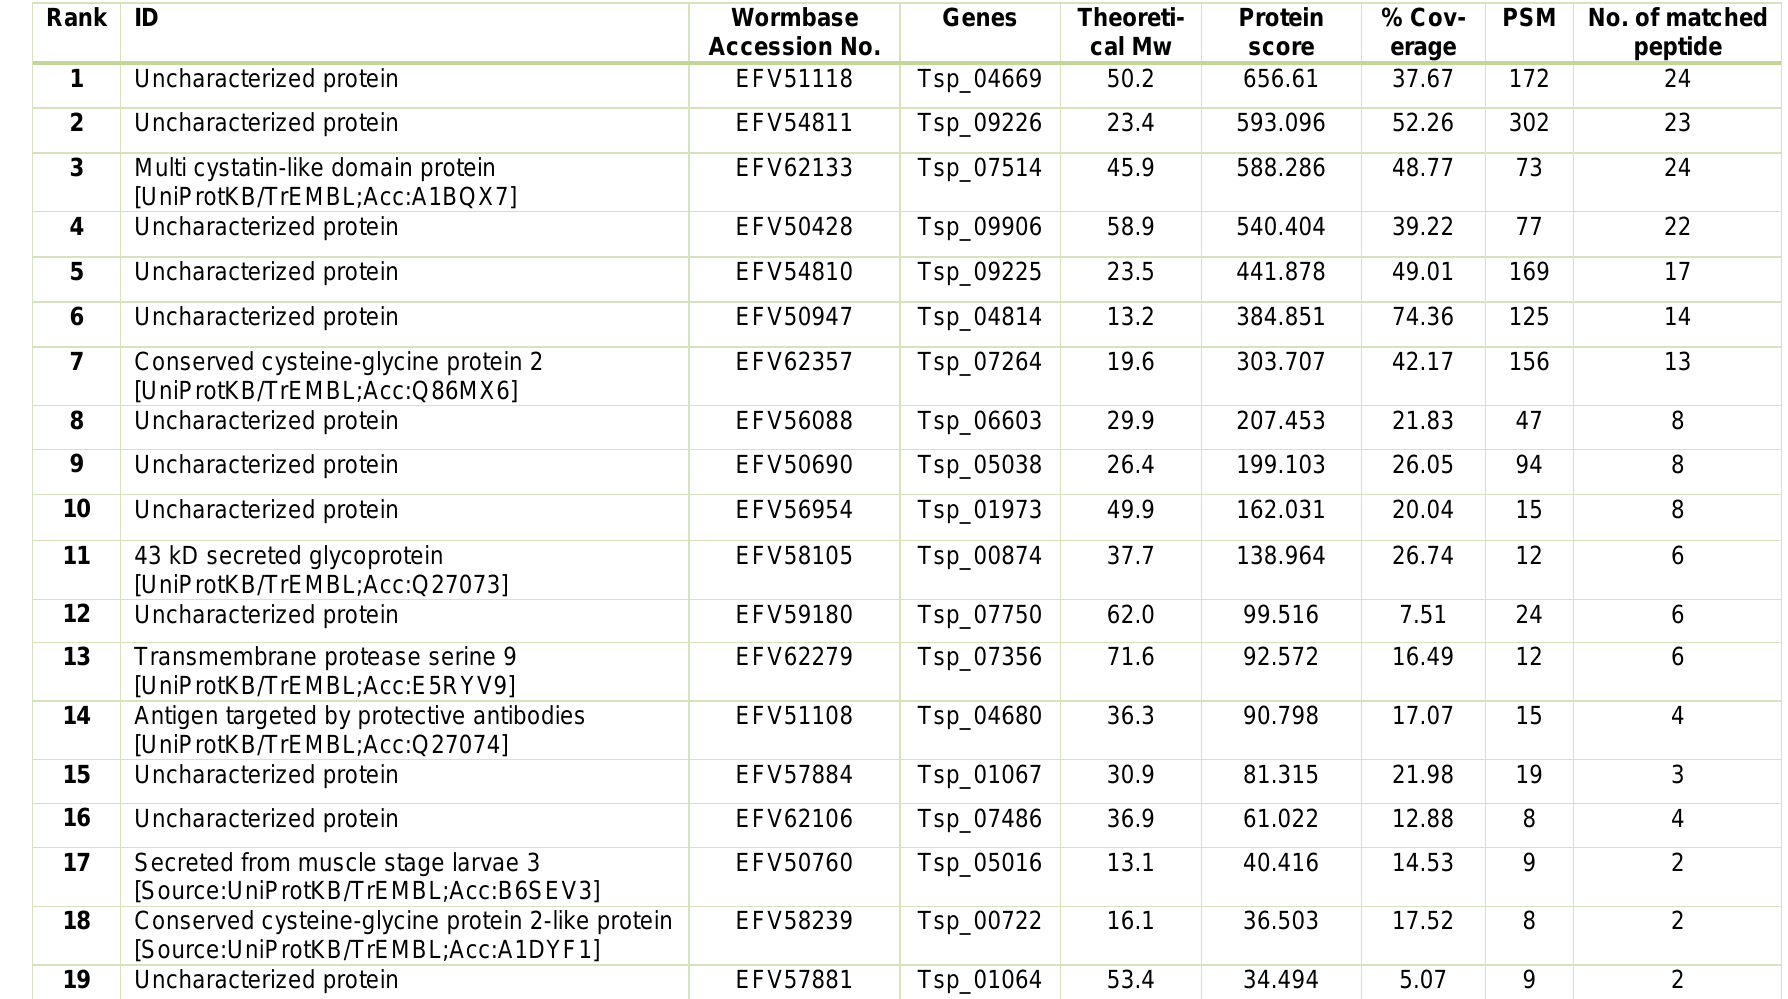
Table 1: Identification of proteins in ES L1 fraction by mass